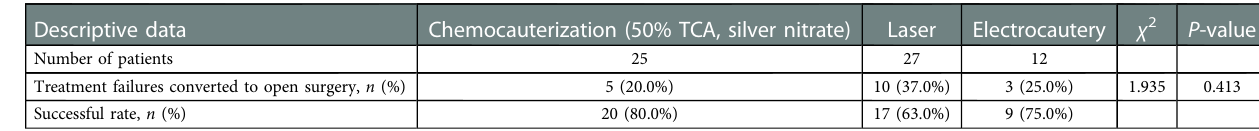
TABLE 3 Summary of results comparing different de-epithelialization techniques.